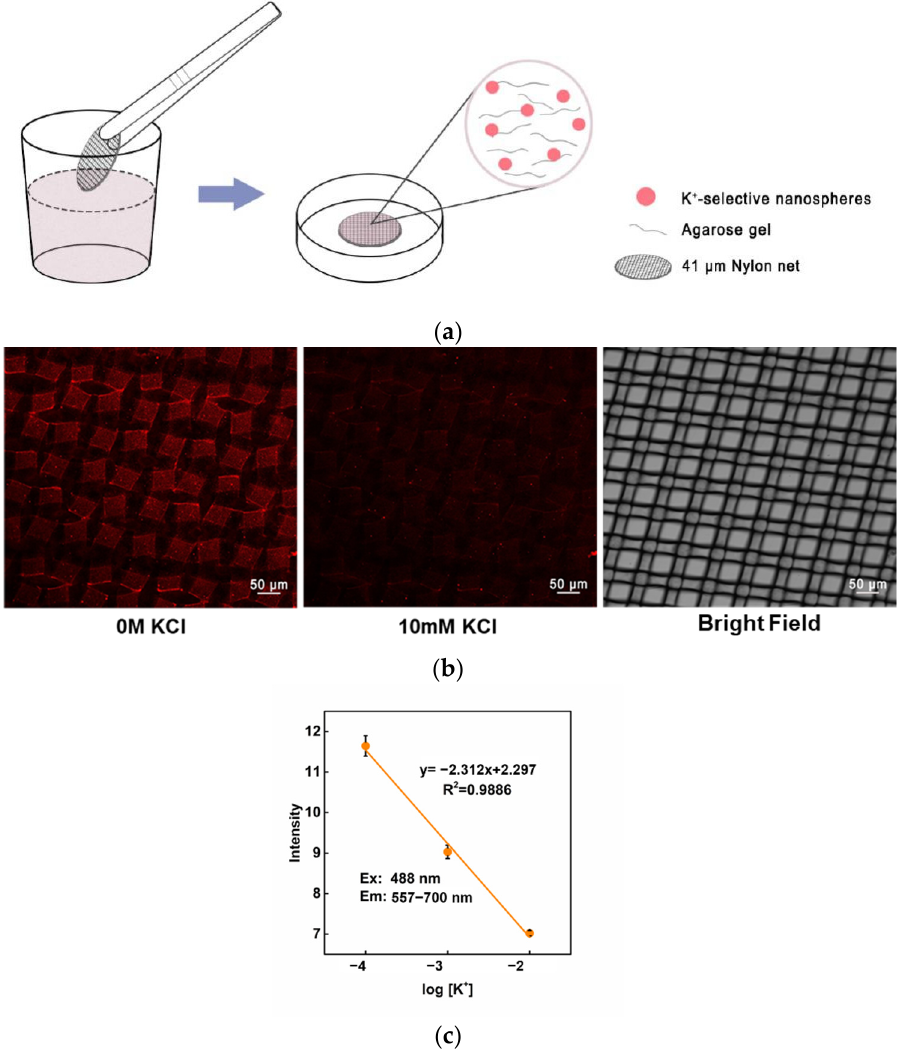
Figure 5. ( a ) Preparation process of a nylon filter paper containing the K + nano-optodes immobilized in agarose hydrogel; ( b ) fluorescence confocal microscope images for the K + sensing paper in fluorescence (with 0 and 10 mM KCl) and bright-field mode; ( c ) the K + response of the paper quantified from the red emission (557 to 700 nm) intensity of SDs. Excitation: 488 nm.